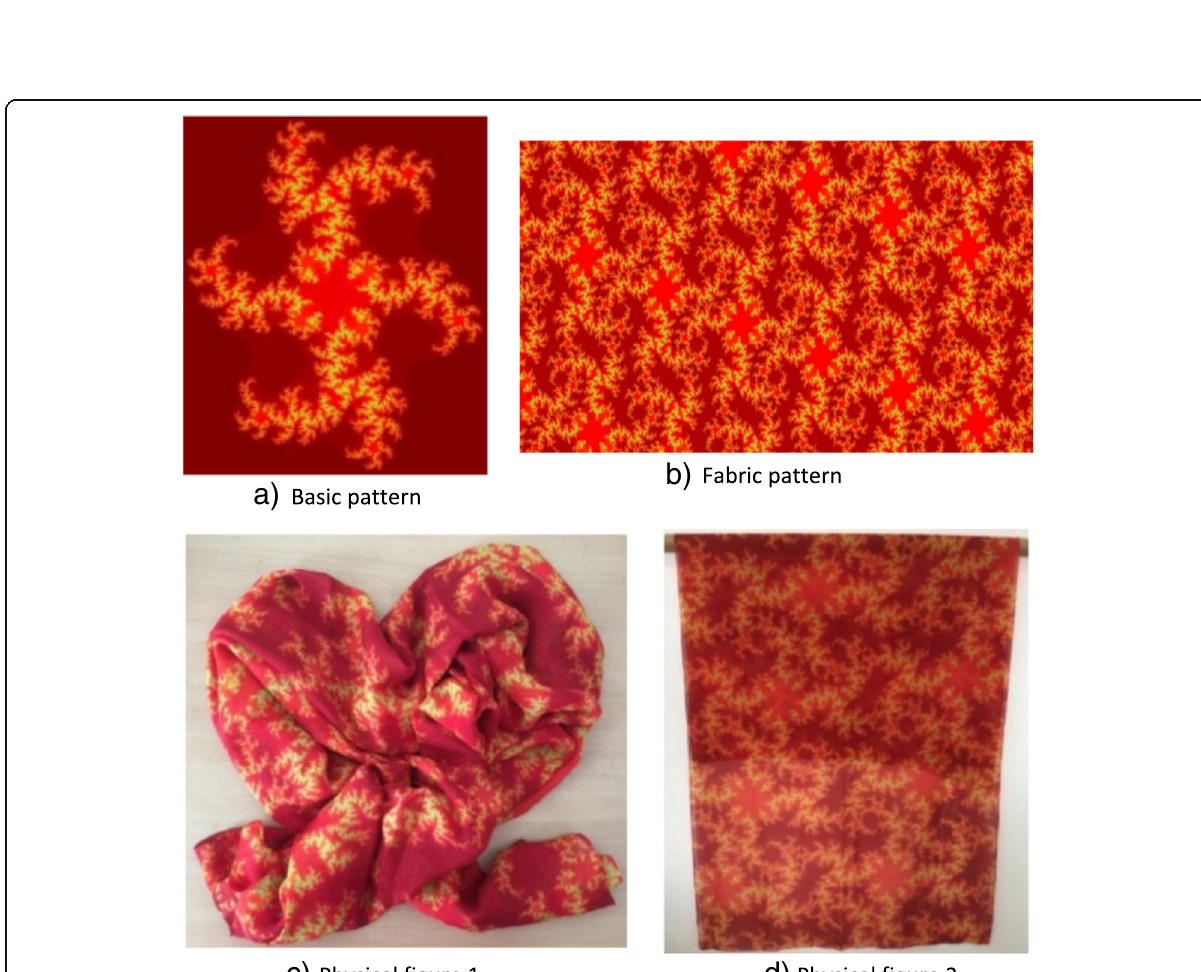
Fig. 19 Printing pattern design of garment fabrics